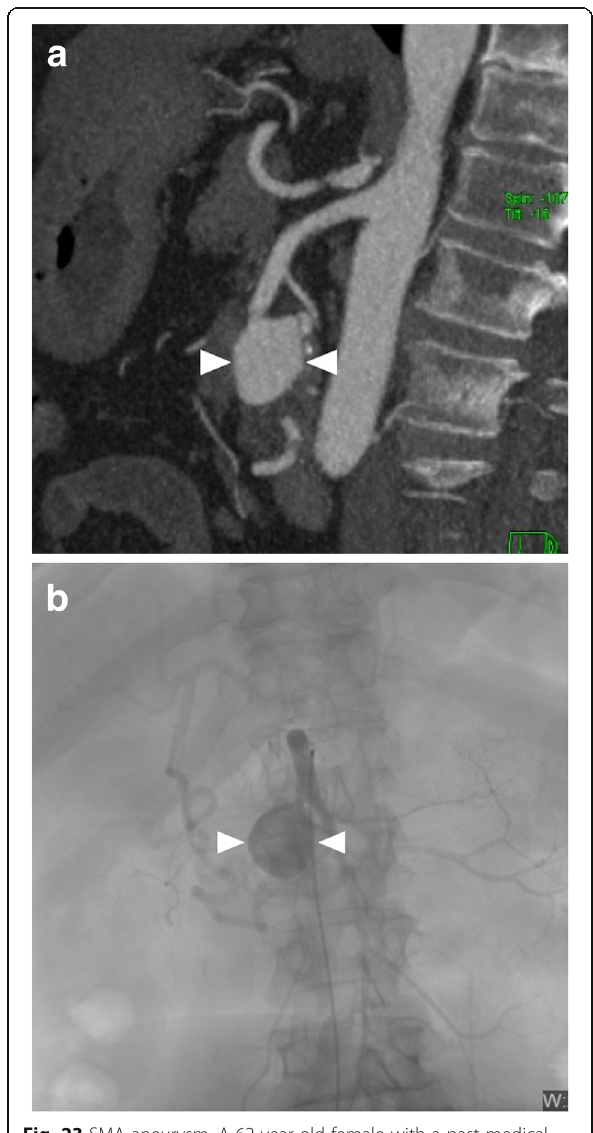
Fig. 23 SMA aneurysm. A 62-year-old female with a past medical history of hypertension and type 2 diabetes now presents to ED with diffuse abdominal pain. a Sagittal plane reformatted post- contrast CT image demonstrates a large saccular aneurysm (arrowheads) originating from the SMA trunk. b Catheter angiography confirmed the presence of the aneurysmal sac (arrowheads) originating from the SMA. The aneurysm was successfully embolized with coils in the same